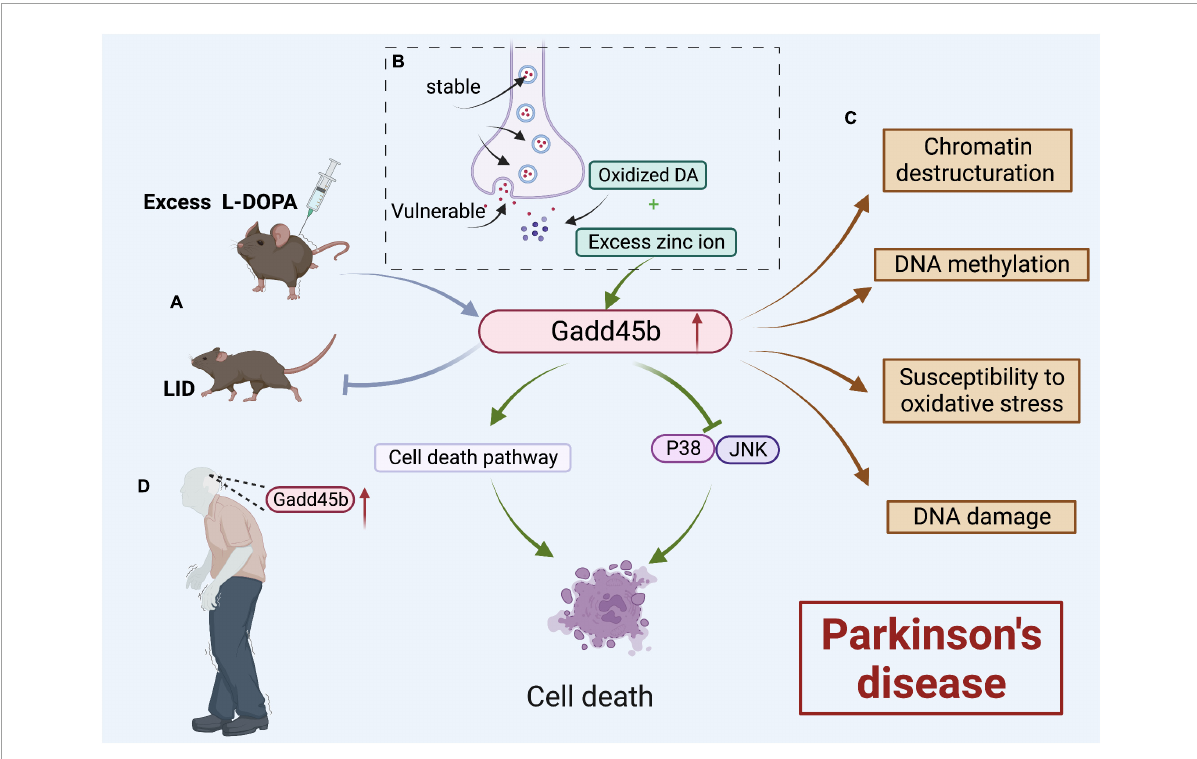
FIGURE7 Roles of growth arrest and DNA damage-inducible beta (Gadd45b) in Parkinson’s disease. (A) Gadd45b could prevent LID caused by excessive L-DOPA. (B) Oxidized DA and Excess Zn2+ could increase Gadd45b, which induced cell death by inhibiting the JNK/P38 signaling pathway and promoting the cell death process. (C) Gadd45b may be related to chromatin destructuration, DNA methylation, susceptibility to oxidative stress and DNA damage. (D) Increased Gadd45b expression in the brain of patients with PD (Figure was created with